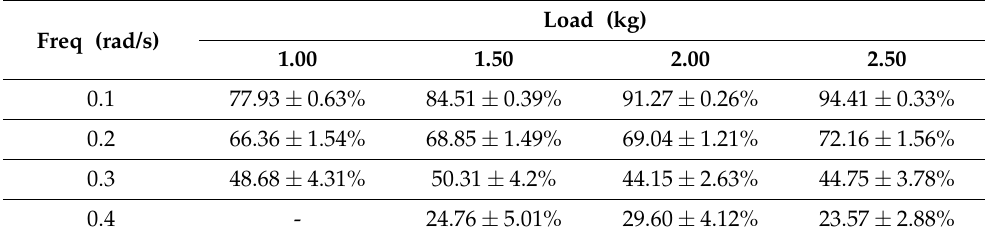
Table 3. Percentage of initial wire length recovered once stationary recovery was